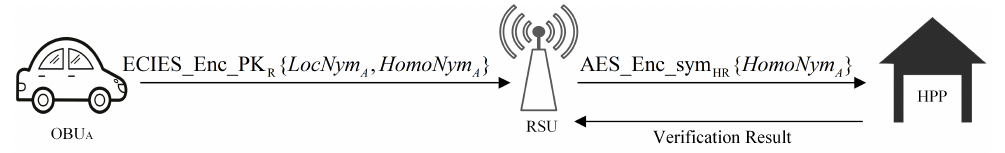
Figure 3. The messages transmitted between entities during the HomoNym enrollment and verifica- tion